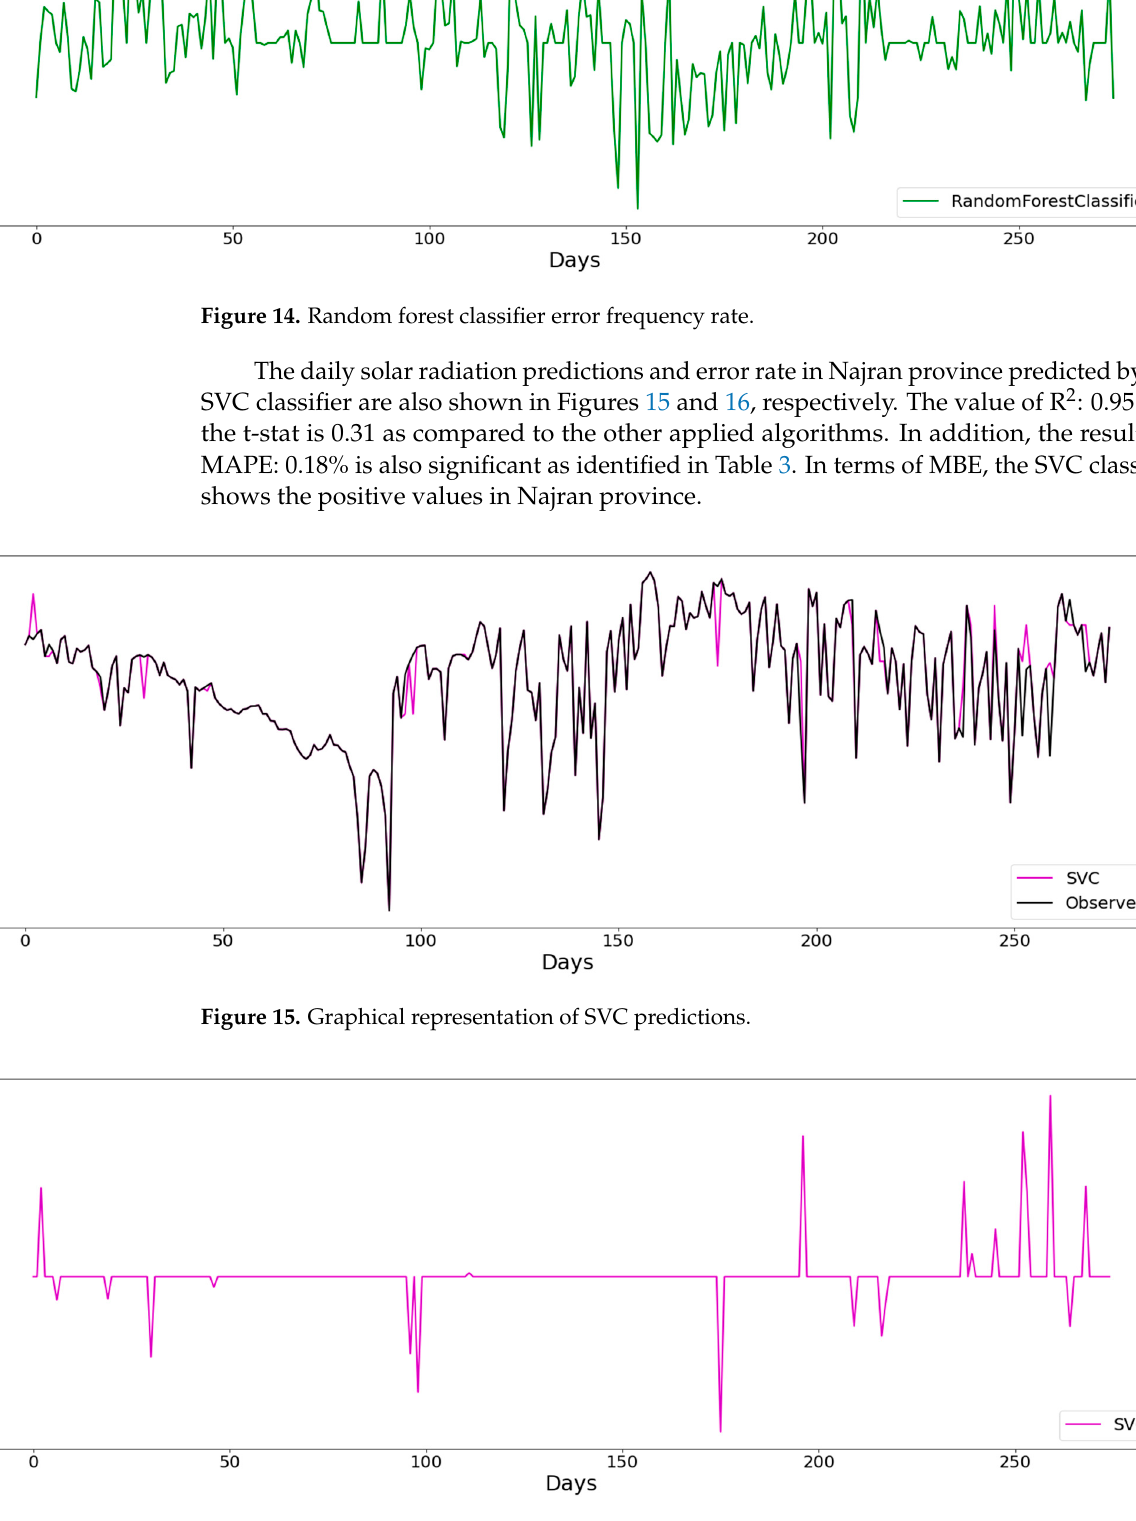
Figure 13. Graphical representation of random forest classifier predictions.